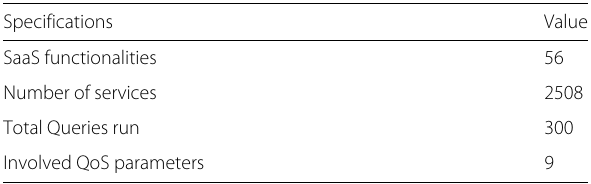
Algorithm 3 EQUILIBRIUM